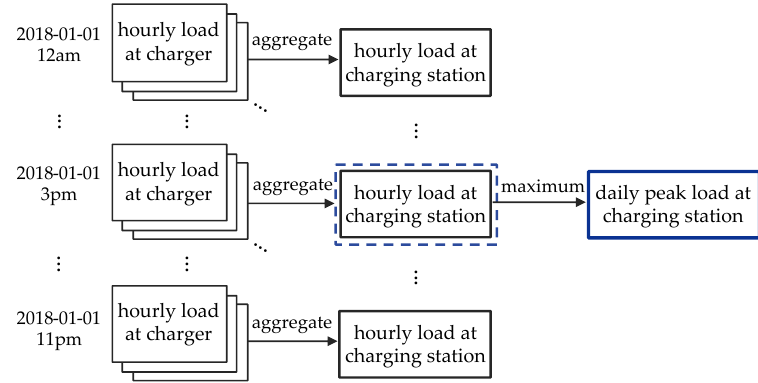
Figure 4. Measurement of the daily peak load at a charging